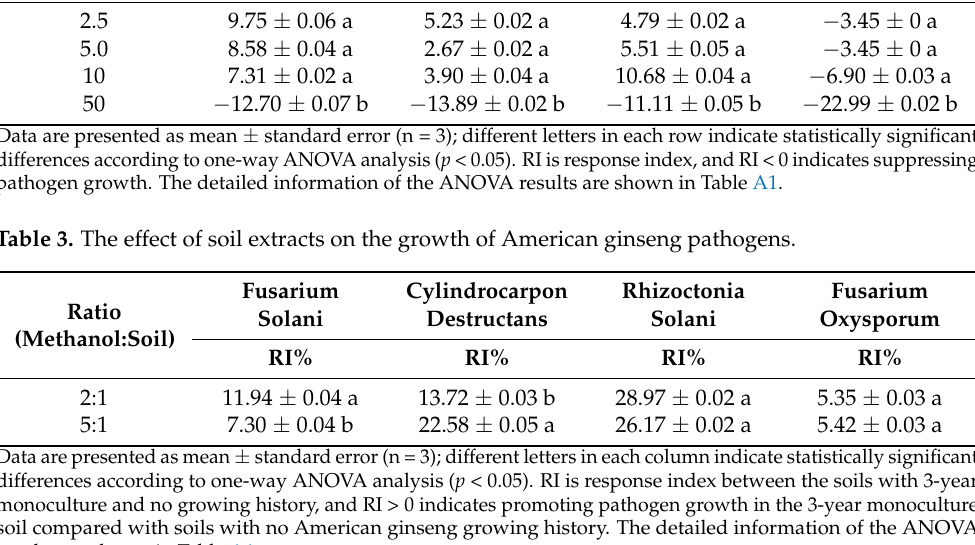
Table 2. The effect of phenolic acid concentrations on the growth of American ginseng pathogens. Concentration (mg L − 1 )